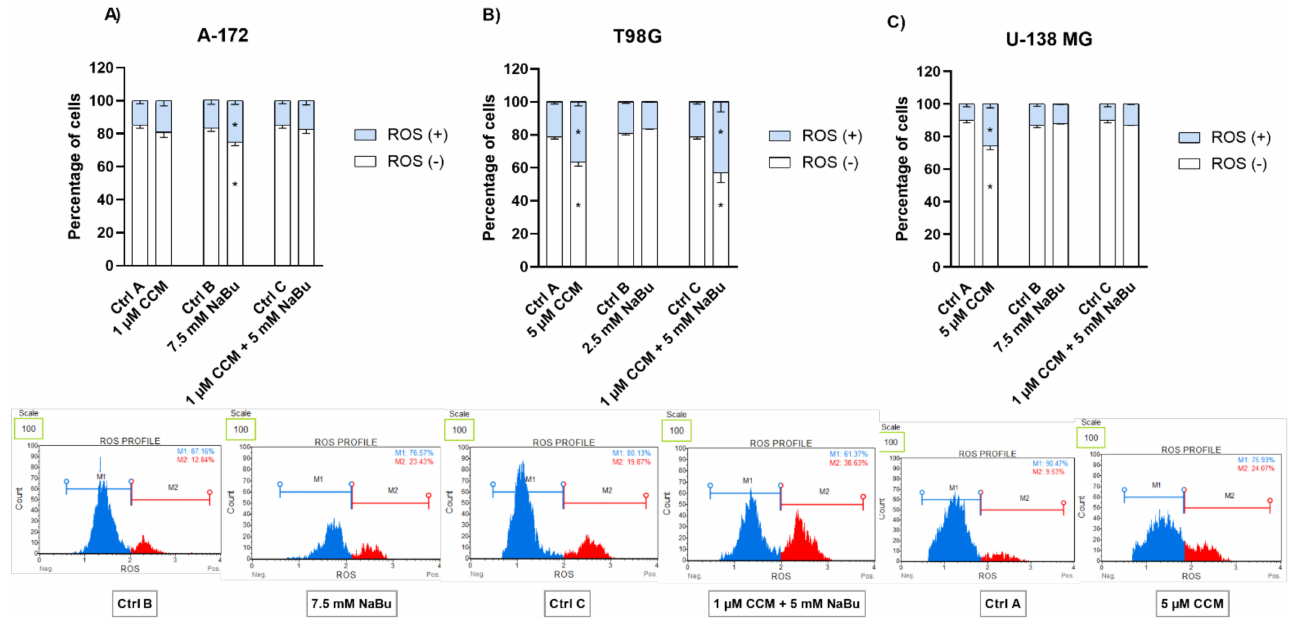
Figure 6. Impact of CCM and NaBu, and their combination on ROS (superoxide) generation in A-172 ( A ), T98G ( B ), and U-138 MG ( C ) cell lines after 48 h of treatment. Percentage of ROS positive (ROS (+)) and negative (ROS ( − )) was detected by flow cytometric analysis after staining with dihydroethidium. Cells treated with vehicle (DMSO, PBS or both) are designated as Ctrl A, Ctrl B, and Ctrl C, respectively. Exemplary histograms are presented below diagrams (Ctrl B and 7.5 mM NaBu refer to A-172 cell line, Ctrl C and combination treatment of 1 µ M and 5 mM NaBu refer to T98G cell line, and Ctrl A and 5 µ M CCM refer to U-138 MG cell line). Values are shown as mean ± SEM calculated from three independent experiments. (*) indicates statistically significant differences from control group, p <